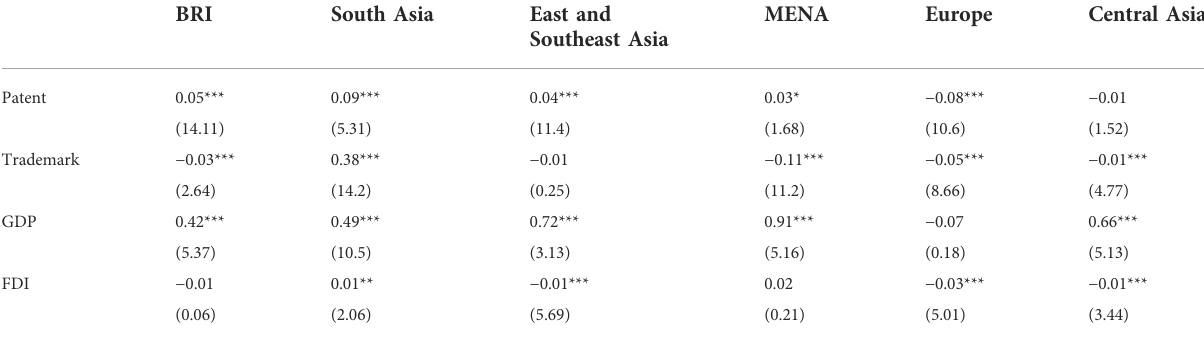
TABLE 7 FMOLS estimates